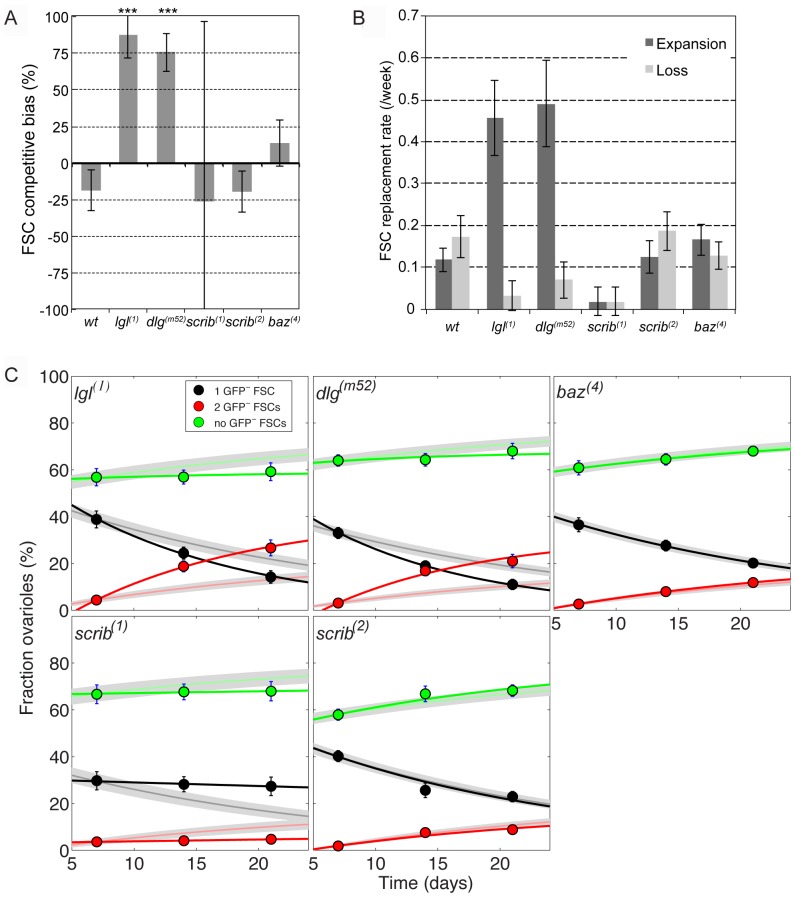

lgl and dlg mutant FSCs, but not scrib or baz mutant FSCs, are hypercompetitive.
A. The competition bias of marked (wildtype or mutant) FSC clones for each genotype relative to the unmarked (wildtype) FSCs, inferred by fitting the clone dynamics to the FSC competition model (Fig. 1C and Methods). A bias of 0 indicates that the marked FSCs undergo neutral competition with the unmarked FSCs; a positive bias indicates that the marked FSCs are more competitive than the unmarked FSCs; and a negative bias indicates that the marked FSCs are less competitive than the unmarked FSCs. Error bars = S.E. Stars indicate that the bias is significantly different from zero (p<0.001, Table S3). B. The rate of replacement of marked (wildtype or mutant) FSCs and unmarked (wildtype) FSCs for each genotype is similarly obtained from the model. The expansion/loss rates correspond respectively to r
+, r
- in Fig. 1C. Error bars = S.E. C. The observed and predicted fraction of ovarioles with 0, 1 or 2 GFP- FSCs at 7, 14 and 21 dphs for each genotype. Data points indicate experimental measurements (error bars = S.E.), faint lines and grey regions indicate the mean and 95% confidence intervals assuming no change in FSC behavior from wildtype, except for labeling efficiency. Solid lines show the Maximum Likelihood Fits with changes in both the competitive bias and the average FSC replacement rate according to the parameter values in panels A,B. The observed values for lgl1 and dlgm52 deviate substantially from the predicted values whereas the observed values for scrib2 and baz1 are closely aligned with the predicted values. The observed values for scrib1 deviate substantially from the predicted values because the replacement rate, but not the bias, is significantly different from wildtype.